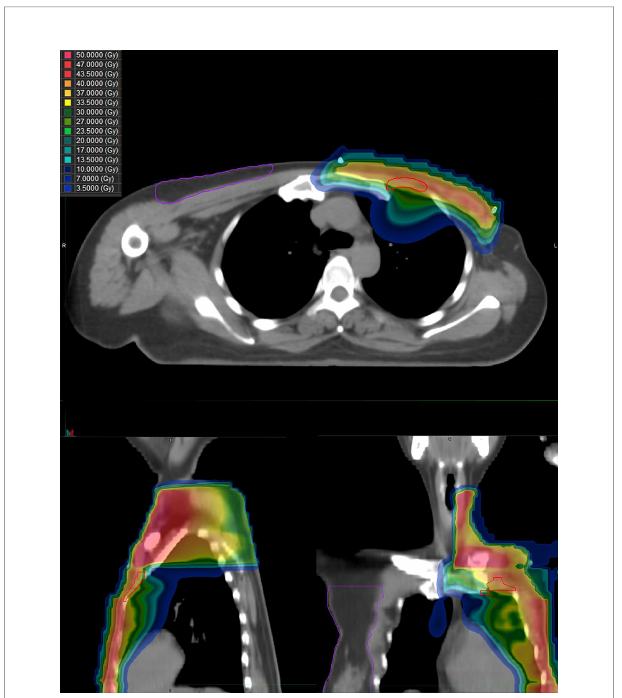
FIGURE 4 | The dose distribution of PMRT the patient received for breast cancer. Upper image, horizontal view; left image, sagittal view; and right image, coronal